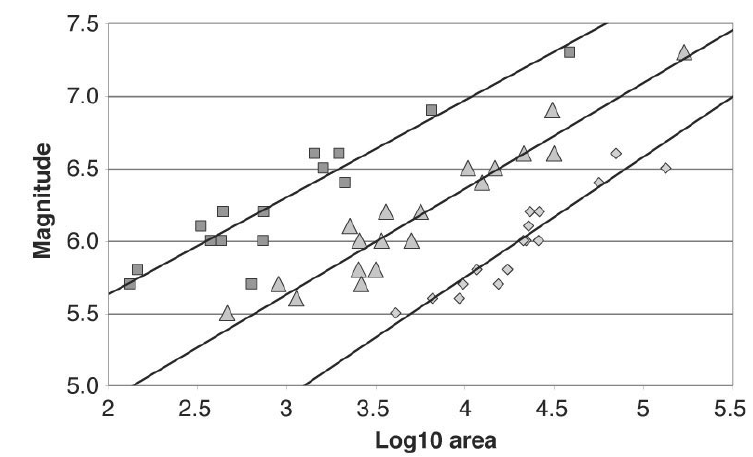
Fig. 4. Moment magnitude as a function of the areas, in km 2 , shaken at or greater than MMI V, VI, VII (mod- ified from Toppozada and Branum,